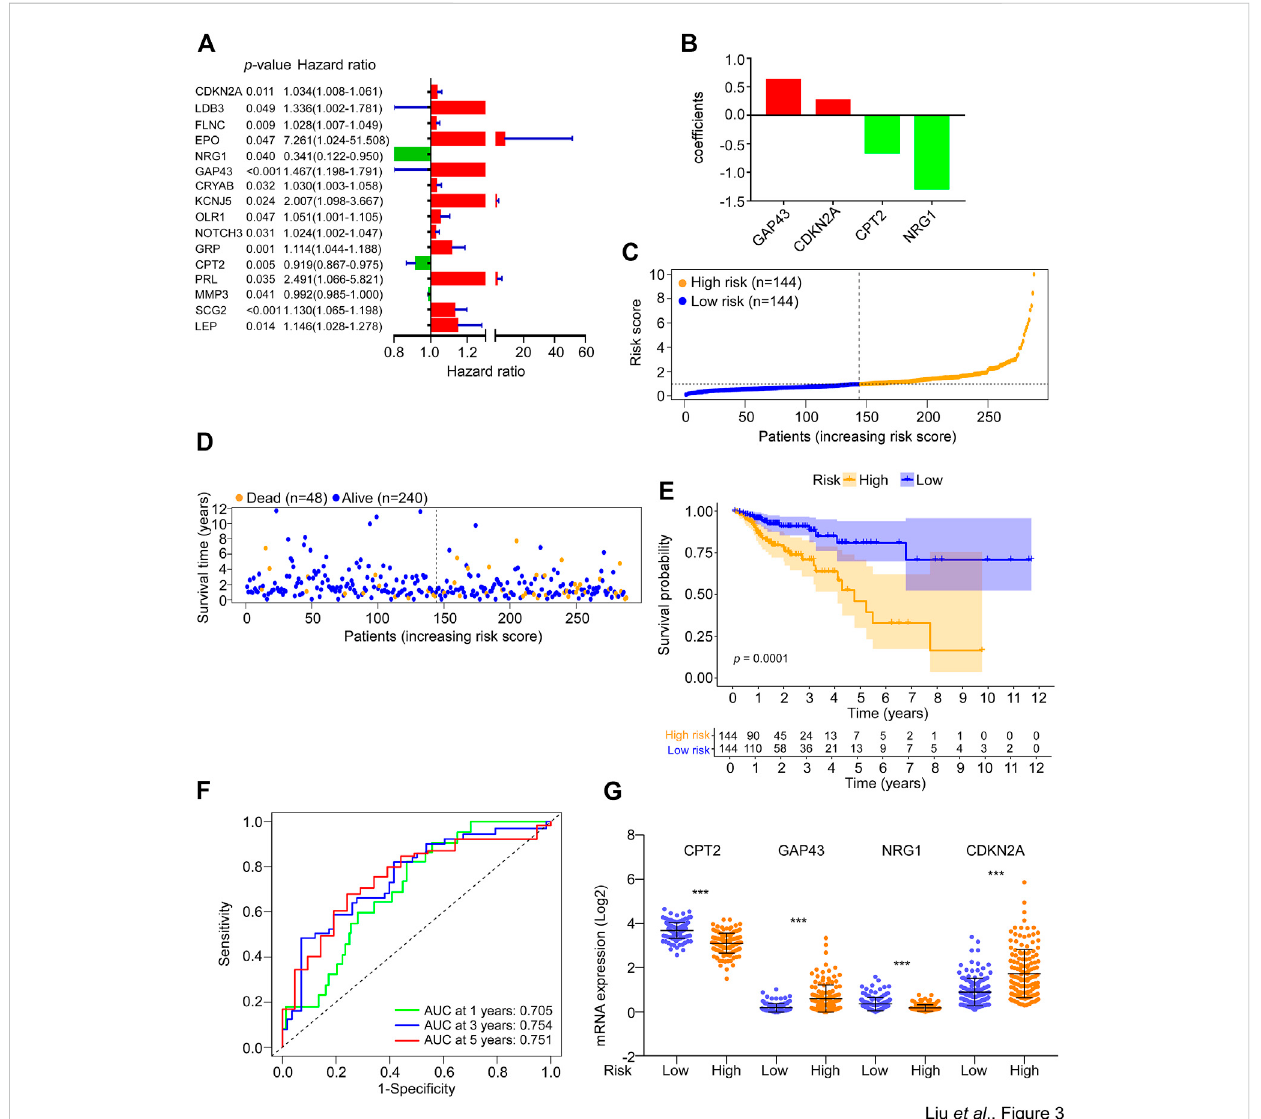
FIGURE 3 ConstructionofSGs-relatedgenesignatureforprognosisprediction. (A) The233DESGGswereusedforunivariatecoxregressionanalysesbetween mRNA expression and overall survival. The hazard ratio values of the 17 genes with signi fi cant change ( p < 0.05) were used to generate a forest plot. (B) The 17 genes from (A) were used to perform multivariate cox regression analyses between mRNA expression and overall survival. The coef fi cients of four optimal genes selected by the multivariate cox regression analyses were shown. (C) The risk score of each sample in the risk train cohort was calculated with the risk score formula. The risk score was used to generate the risk curve. (D) The risk score and overall survival time of each patient were used to generate a scatterplot with survival status as colored by blue (Alive, n = 240) or orange (Dead, n = 48). (E) Kaplan-Meier curves for the overall survival (OS) of CRC patients were strati fi ed by risk core obtained from (C) . Log-rank test was used to compare the differences between the low- and high-risk groups of the risk train cohort. (F) The prognostic performance of the risk score was veri fi ed by AUC of time-dependent ROC curves. (G) The mRNA expression levels of CPT2, GAP43, NRG1, and CDKN2A in the low- or high-risk groups of the risk train